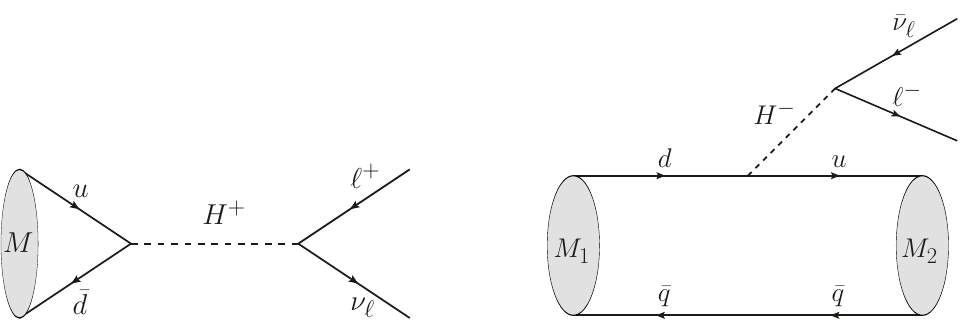
Figure 4. Diagrams contributing to leptonic (left) and semi-leptonic (right) decays in the 2HDM. where the new effective operators